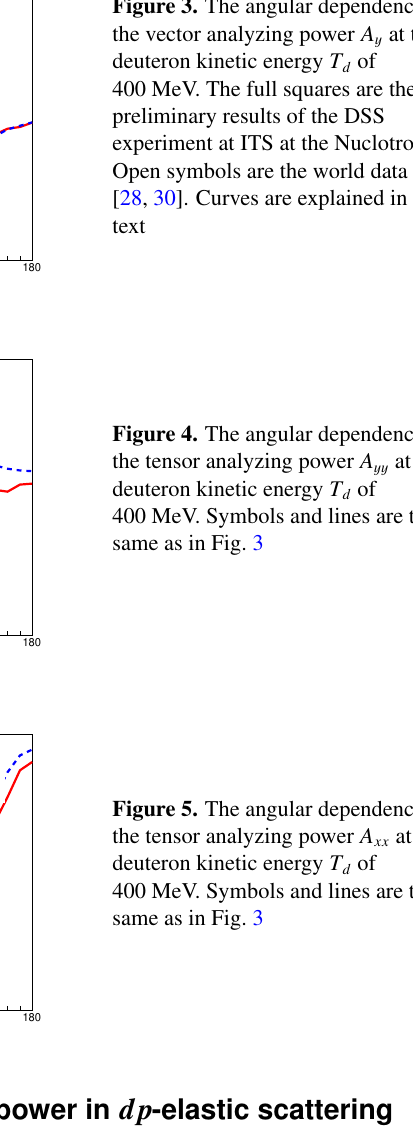
Figure 3. The angular dependence of the vector analyzing power A y at the deuteron kinetic energy T d of 400 MeV. The full squares are the preliminary results of the DSS experiment at ITS at the Nuclotron. Open symbols are the world data [28, 30]. Curves are explained in the text